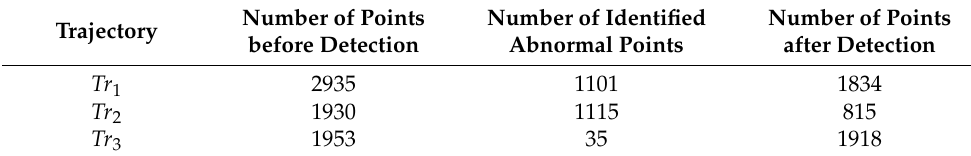
Figure 8. Kinematic estimation in the first detection round on Tr 1 . Table 4. Trajectory points in different states.